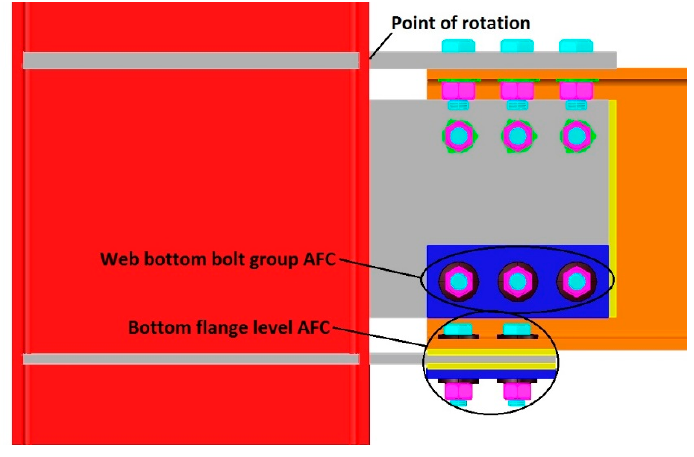
Figure 1. The SHJ layout with AFCs [6].